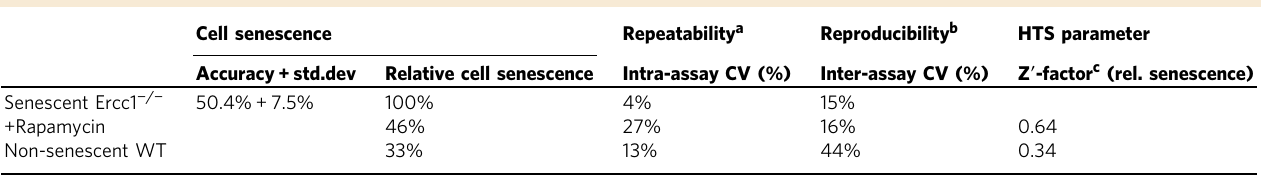
Table 1 Bioassay quali fi cation parameter